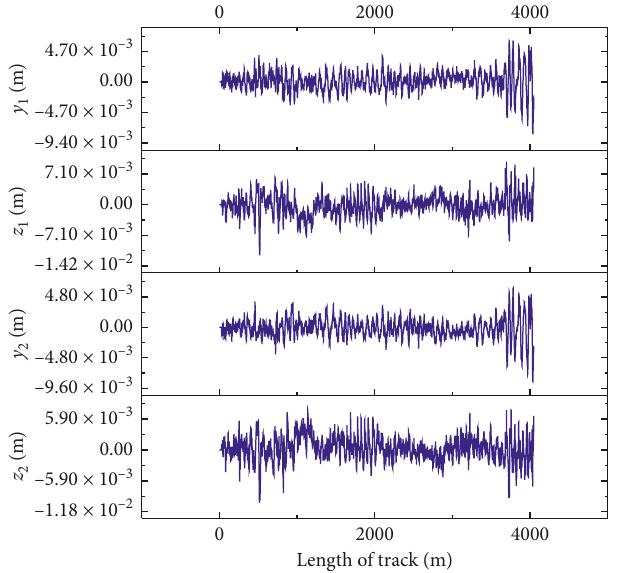
Figure 3: Irregularity curves of German low disturbance line.